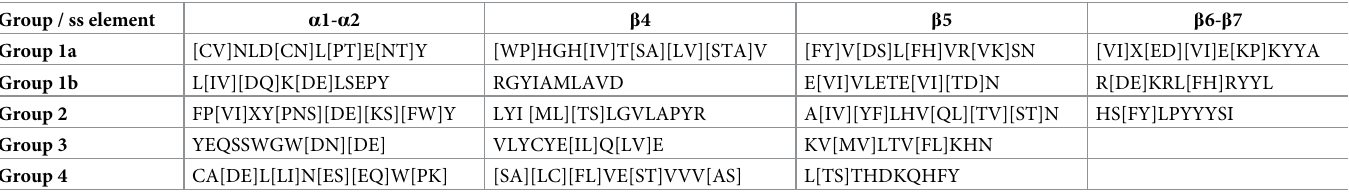
Table 1. Regular expressions for key sequence motifs of NATs Groups 1 to 4. All regular expressions were calculated using MEME from MEME Suite [75]. Group / ss